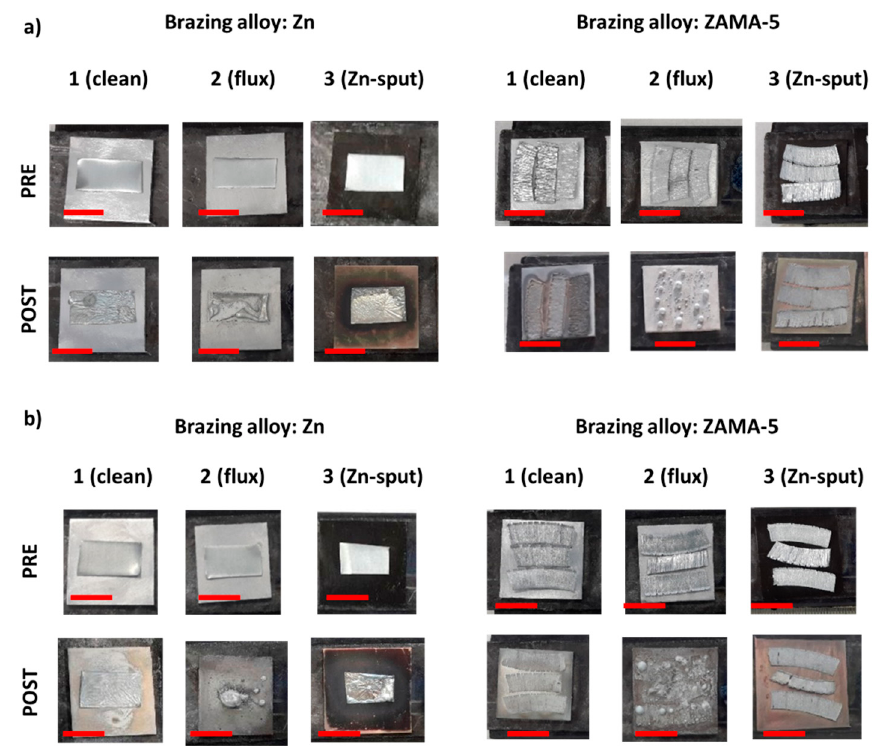
Figure 2. Macroscopic appearance of samples before and after brazing. ( a ) Al5182 substrate and ( b ) Al6016 substrate. Scale bar: 1 cm.